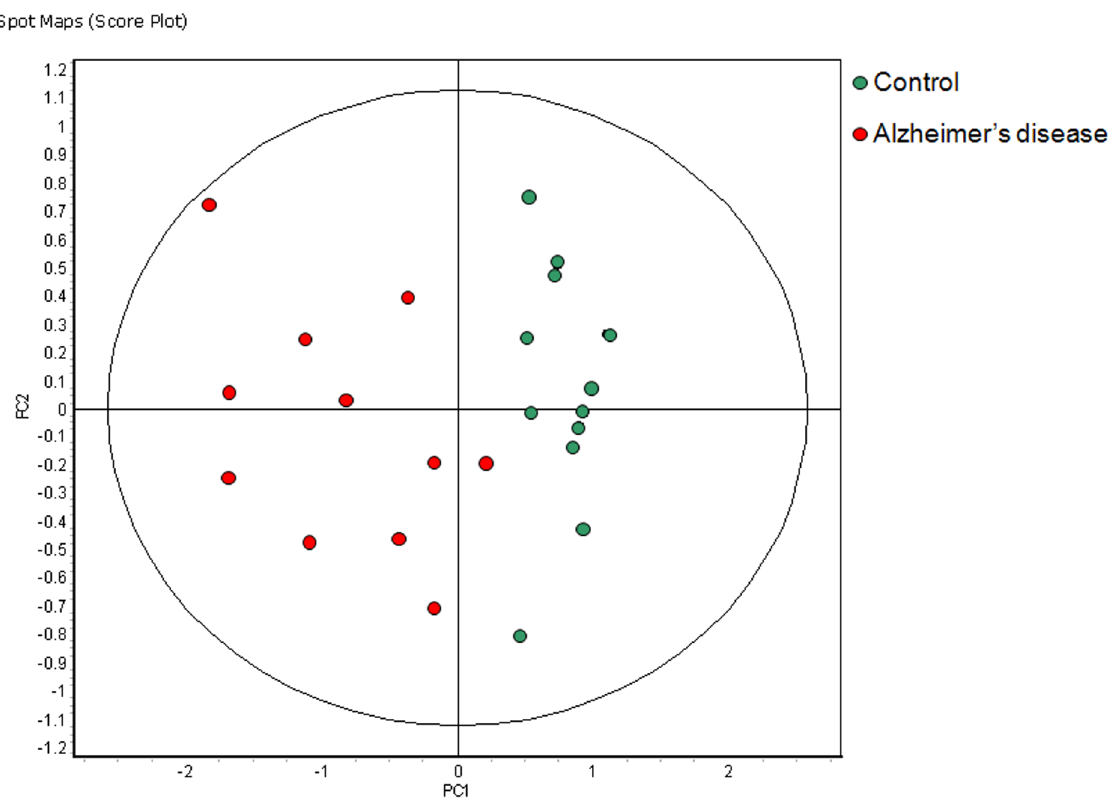
Figure 3. Principle component analysis of the 11 Alzheimer’s disease model (red) and the 12 control samples (green) collected from 4 diseased and 4 control mice at 3 time points: 32, 36, and 40 weeks of age. A sample from one of the diseased mice was not obtained at 32 weeks of age. A classifier based on 84 features was able to correctly classify the 23 samples of the training set with 100% accuracy. (PC1=62.0, PC2=11.9).